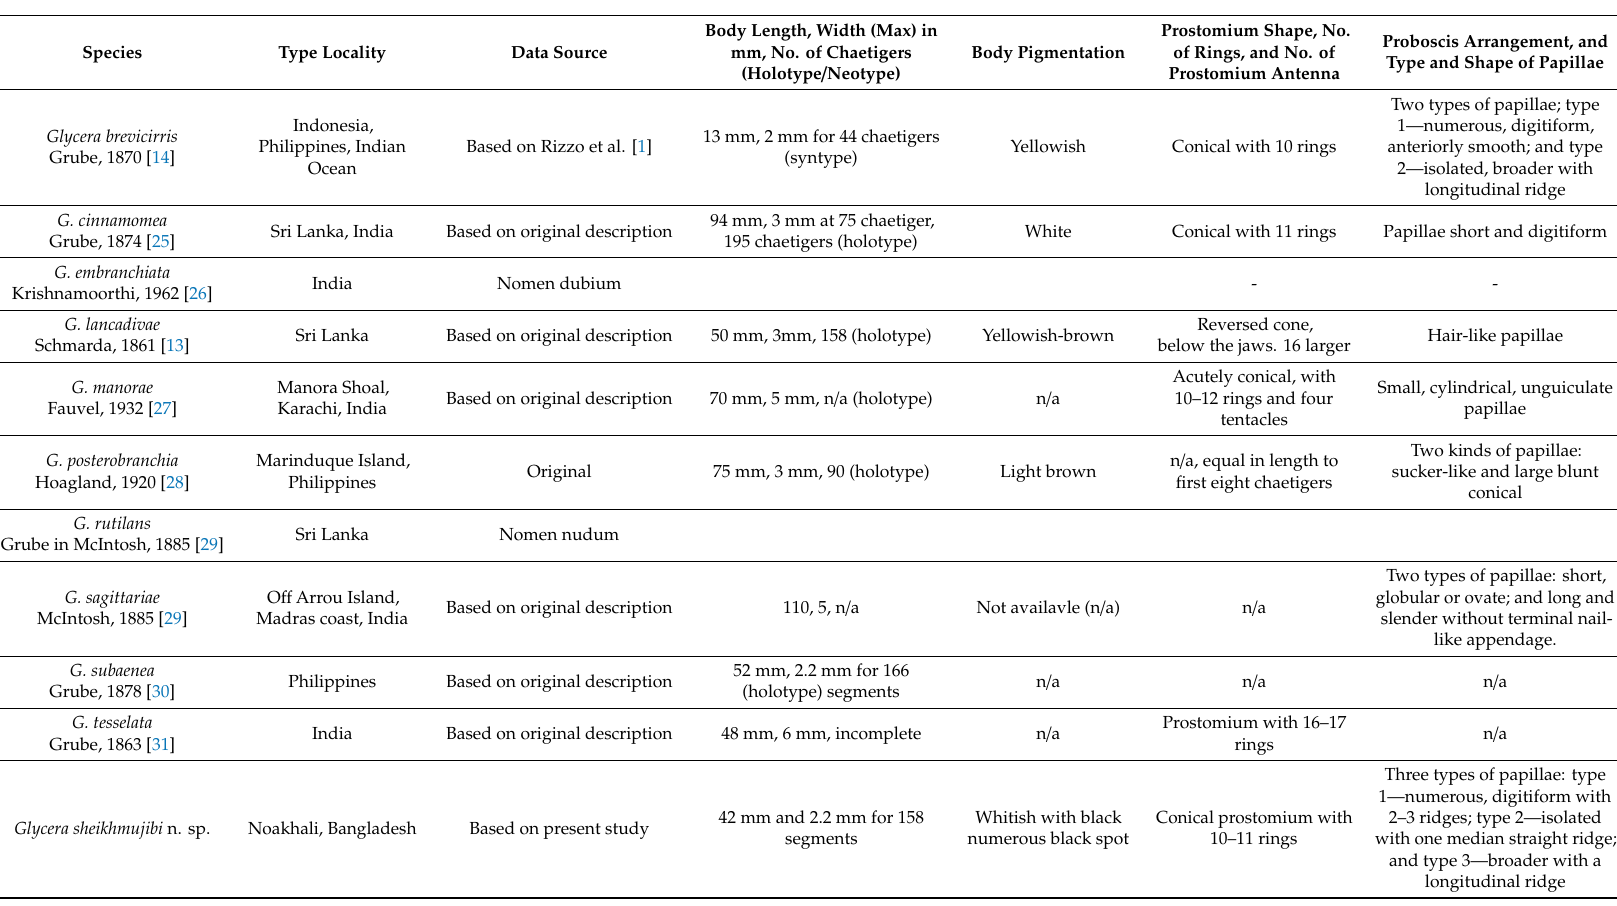
Table 1. List of Glycera recorded from near the Bay of Bengal Region, with their comparative characteristics, as per World Register of Maine Species, WoRMS [24].